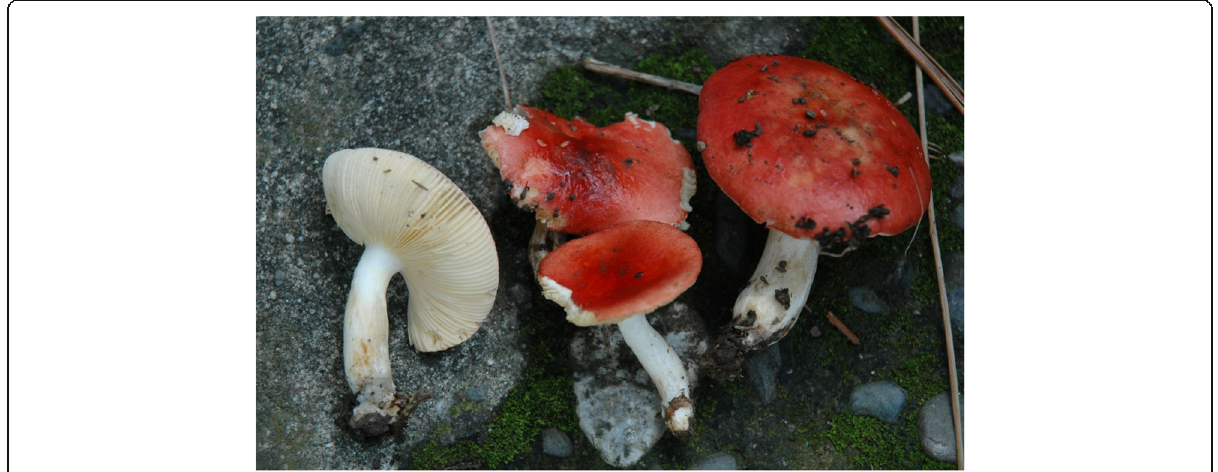
Fig. 8 Russula abbottabadensis (FH00304589, holotype), field appearance. Bar = 1 cm. Photo: